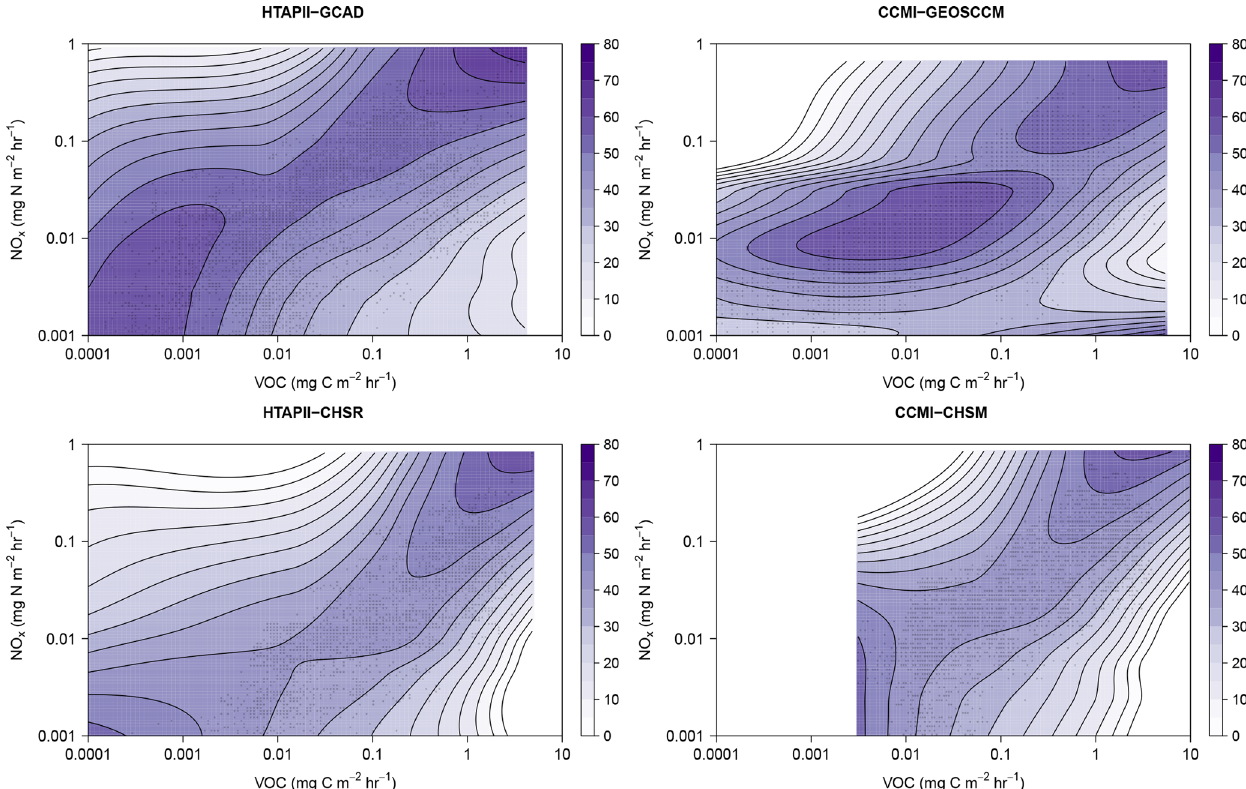
Figure 14. Isopleths of ozone concentration in parts per billion (ppb) as a function of NO x and VOC emissions over the domain. The dots in each panel indicate the locations (in VOC and NO x space) that the model ozone data